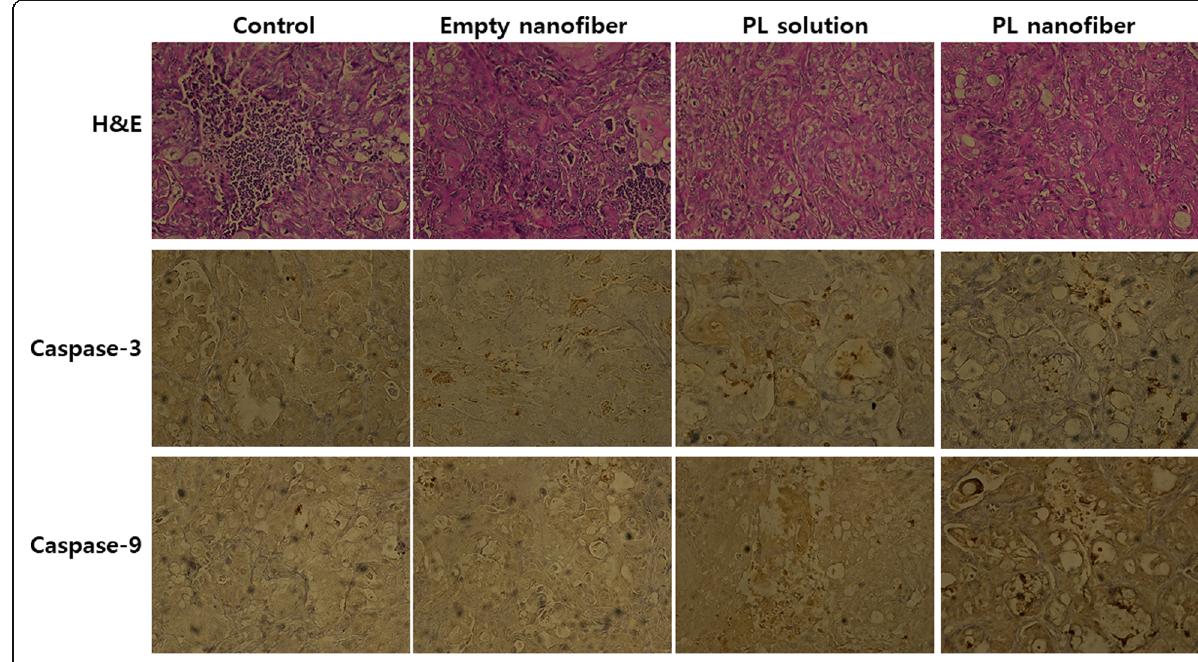
Fig. 8 Immunohistochemical staining (× 400) of HuCC-T1 tumor tissues. Each tumor tissues were stained with BAX, caspase-3, 7, and 9, and